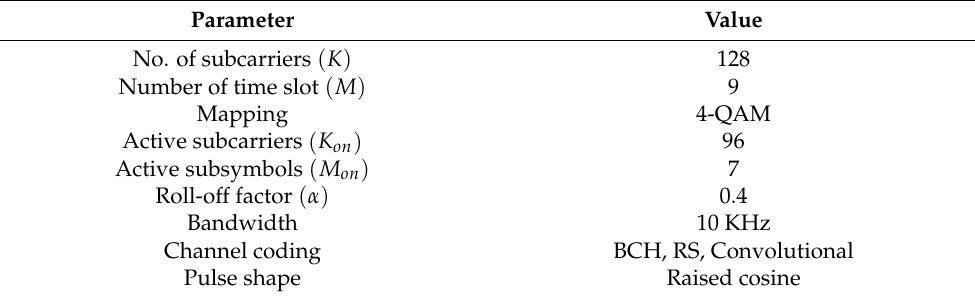
Table 1. Transceiver parameters.